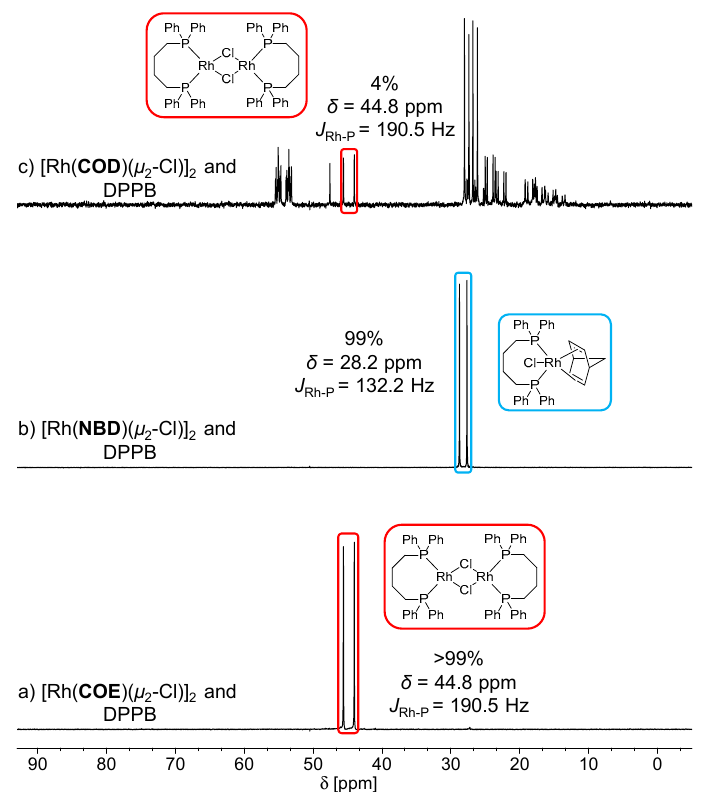
Figure 4. 31 P NMR spectrum of the solution resulting from the in situ reaction of DPPB in THF- d 8 with ( a ) [Rh(COE)( µ 2 -Cl)] 2 , ( b ) [Rh(NBD)( µ 2 -Cl)] 2 , ( c ) [Rh(COD)( µ 2 -Cl)] 2 .